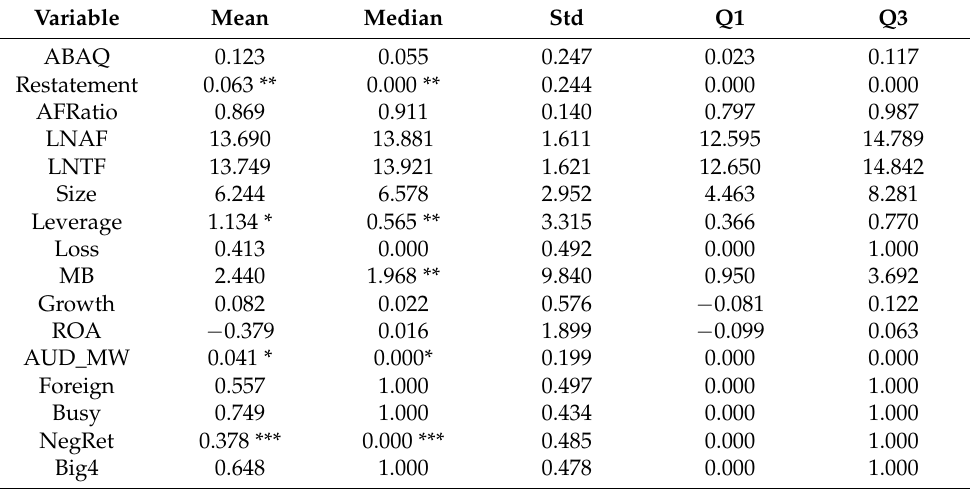
Panel B: Descriptive Statistics for the ABAQ, Restatement, and AF of U.S. sample firms in 1-year post-Rule 3211 period.